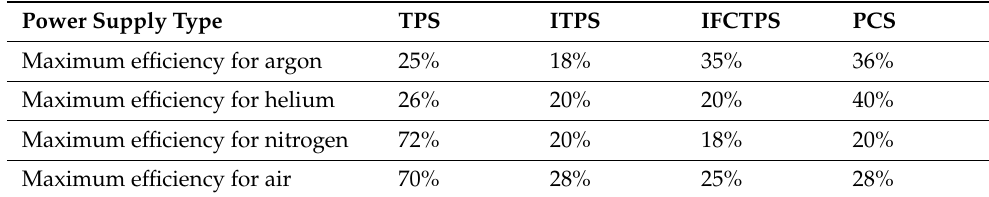
Table 7. Efficiencies of power supplies for a burning discharge in different plasma gases.